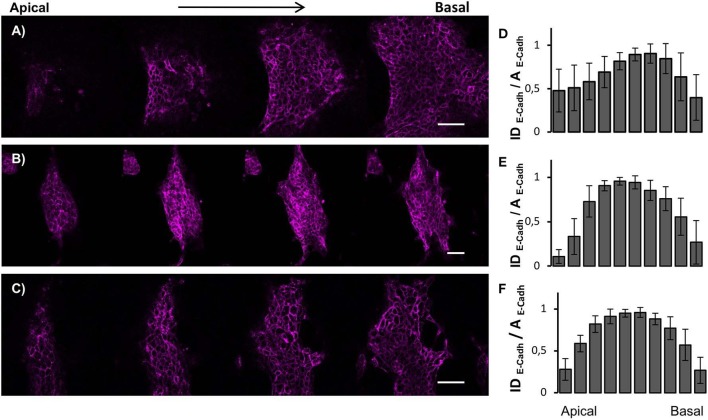
Spatial organization of cell-cell contacts within ESC colonies. Confocal z-scan imaging of E-Cadherin and corresponding fluorescence intensity distribution profiles of ESCs cultured for 72 h on flat control (A,D), ps-350 (B,E), and ps-700 (C,F) surfaces. For each experimental condition, 10 confocal z-scanning were analyzed. Data are mean ± SD. Scale Bar is 50 μm.